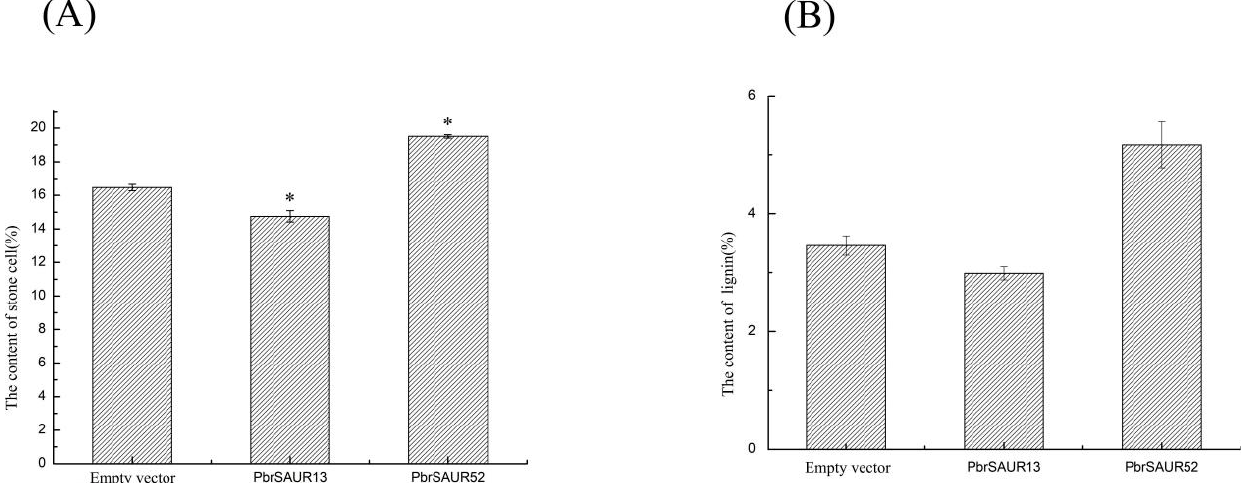
Figure 10. The contents of stone cells ( A ) and lignin ( B ) of PbrSAUR13,52 overexpressed pear fruits. * Significant difference at p < 0.05.